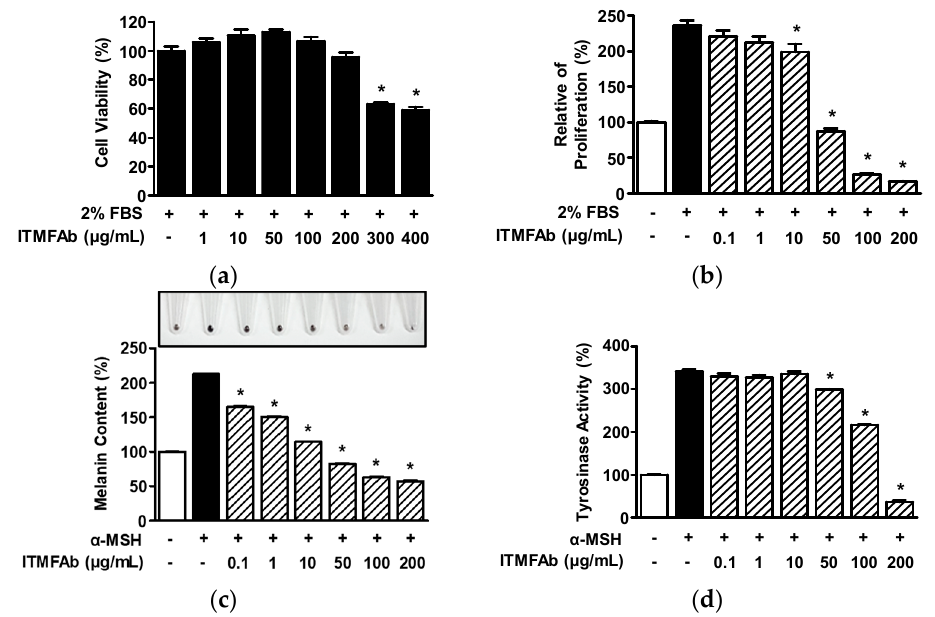
Figure 6. Effects of Impatiens textori Miq. flower absolute on skin whitening-linked responses in B16BL6 melanoma cells. ( a ) Cell viability. B16BL6 melanoma cells in DMEM containing 2% FBS were treated with or without Impatiens textori Miq. flower absolute (ITMFAb; 1–400 µ g/mL) at 37 ◦ C for 48 h. Cell viability levels were determined using a WST assay ( n = 5). Levels in the 2% FBS alone-treated state were considered 100%. * p < 0.05 vs. cells treated with 2% FBS. ( b ) Cell proliferation. B16BL6 melanoma cells were cultured in DMEM with or without 2% FBS in the presence or absence of ITMFAb (0.1–200 µ g/mL) at 37 ◦ C for 48 h. Proliferations were measured using the BrdU incorporation assay described in Materials and Methods ( n = 5). Data are expressed as percentages of responses in the quiescent state. * p < 0.05 vs. cells treated with 2% FBS. ( c , d ) Melanin contents and tyrosinase activities. B16BL6 melanoma cells were incubated in Dulbecco’s modified eagle medium (DMEM) (containing 2% FBS) with or without α -MSH (200 nM) in the presence or absence of ITMFAb (0.1–200 µ g/mL) at 37 ◦ C for 48 h. Melanin contents (( c ); n = 3) and